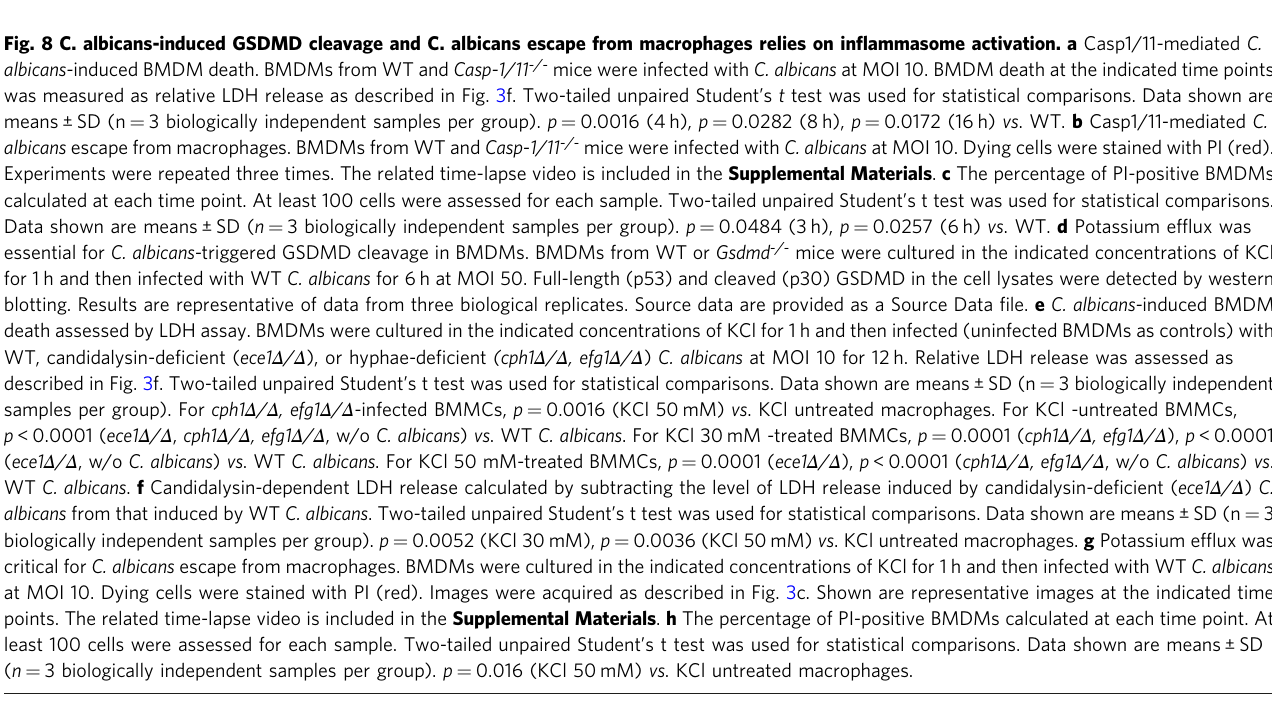
Fig. 8 C. albicans-induced GSDMD cleavage and C. albicans escape from macrophages relies on in fl ammasome activation. a Casp1/11-mediated C. albicans- induced BMDM death. BMDMs from WT and Casp-1/11 -/- mice were infected with C. albicans at MOI 10. BMDM death at the indicated time